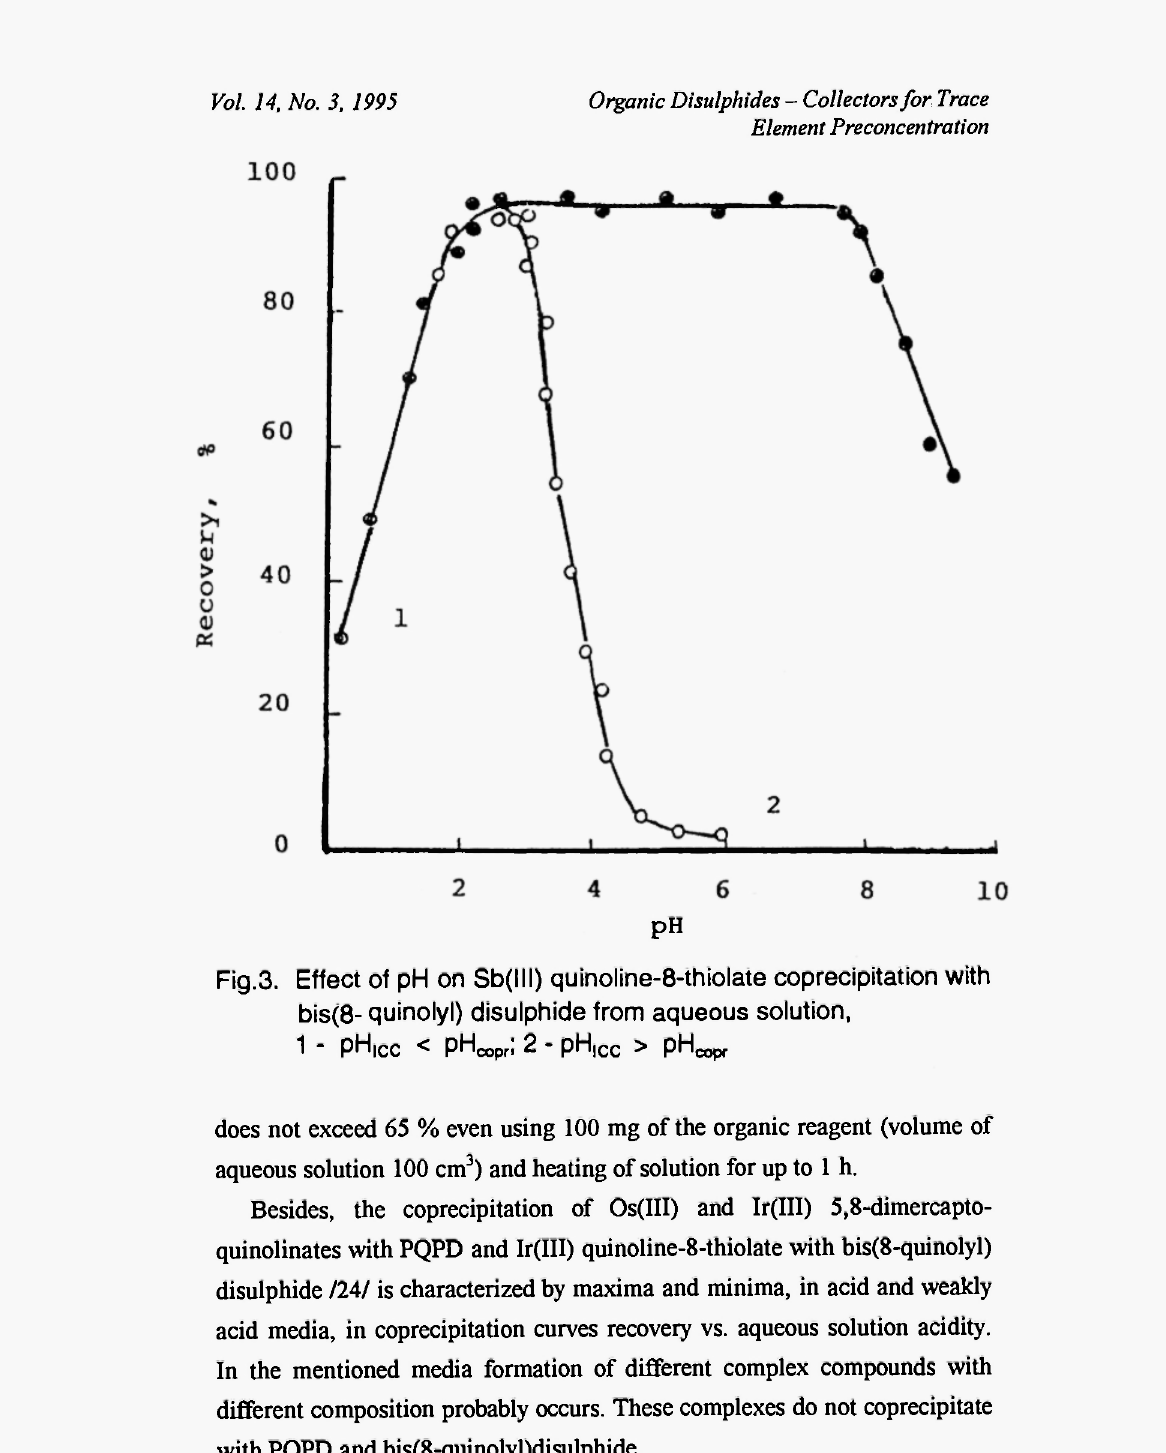
Fig.3. Effect of pH on Sb(lll) quinoline-8-thiolate coprecipitation with bis(8- quinolyl) disulphide from aqueous solution, 1 - pHicc < pHcopr! 2 - pH,cc > pH«^ does not exceed 65 % even using 100 mg of the organic reagent (volume of aqueous solution 100 cm 3 ) and heating of solution for up to 1